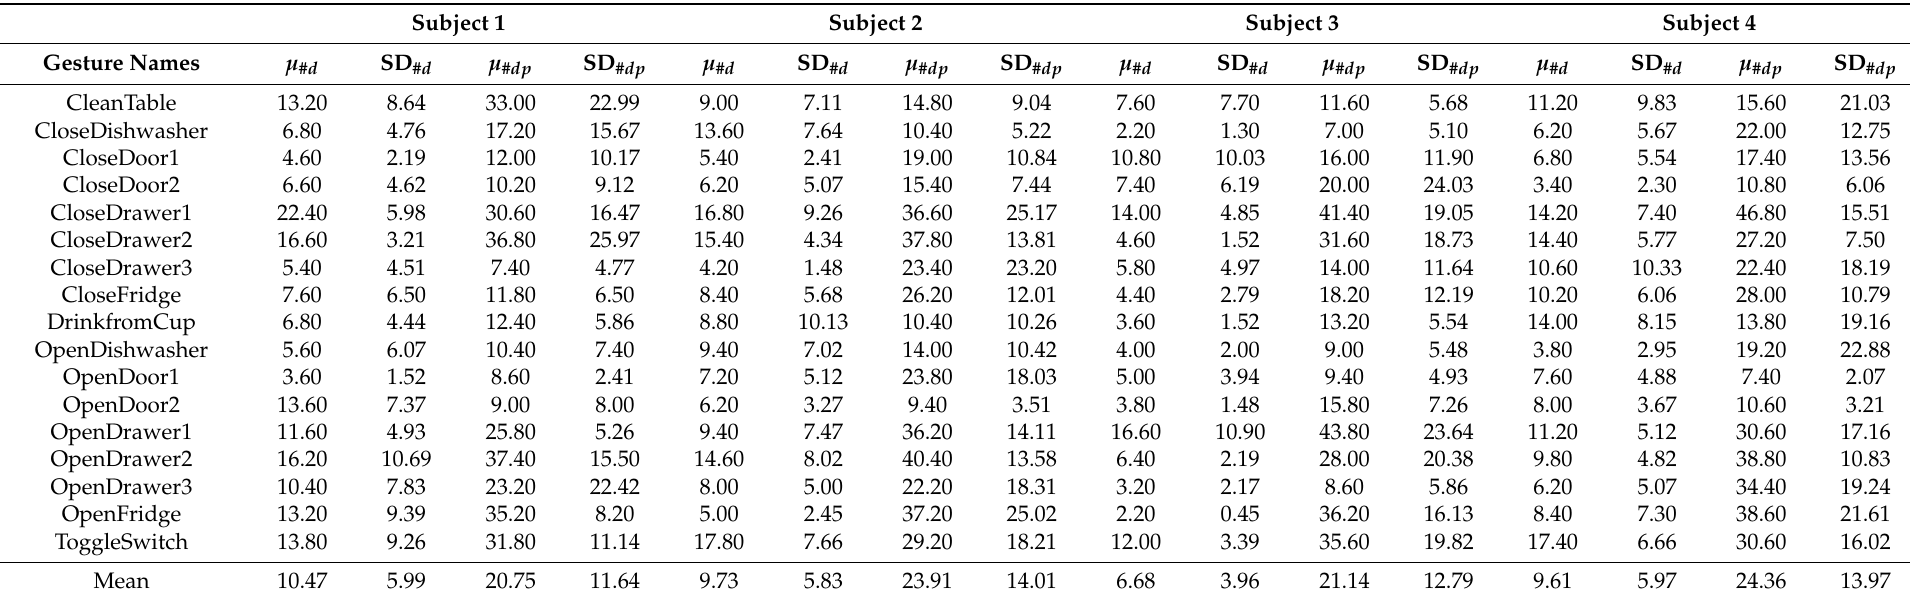
Table 4. Average cut points and selected features obtained by MOFSD-GR ur-CAIM